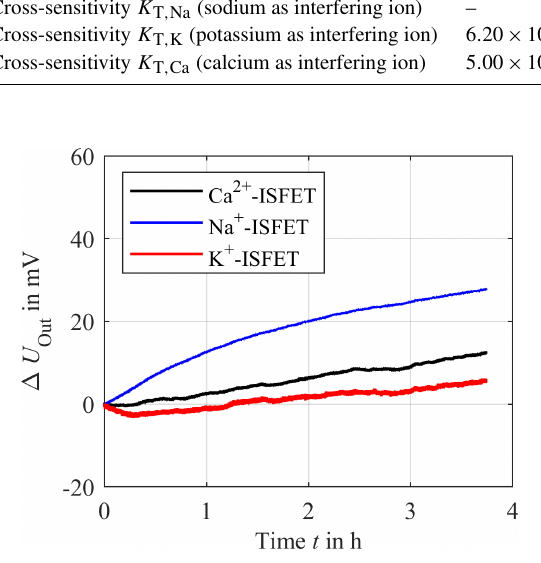
Figure 11. Long-term stability measurement of the sodium ISFET (blue), potassium ISFET (red) and calcium ISFET (black) in deion- ized water with constant concentration of 140mmolL − 1 of sodium chloride, 4mmolL − 1 of potassium chloride and 1mmolL − 1 of cal- cium chloride over a period of about